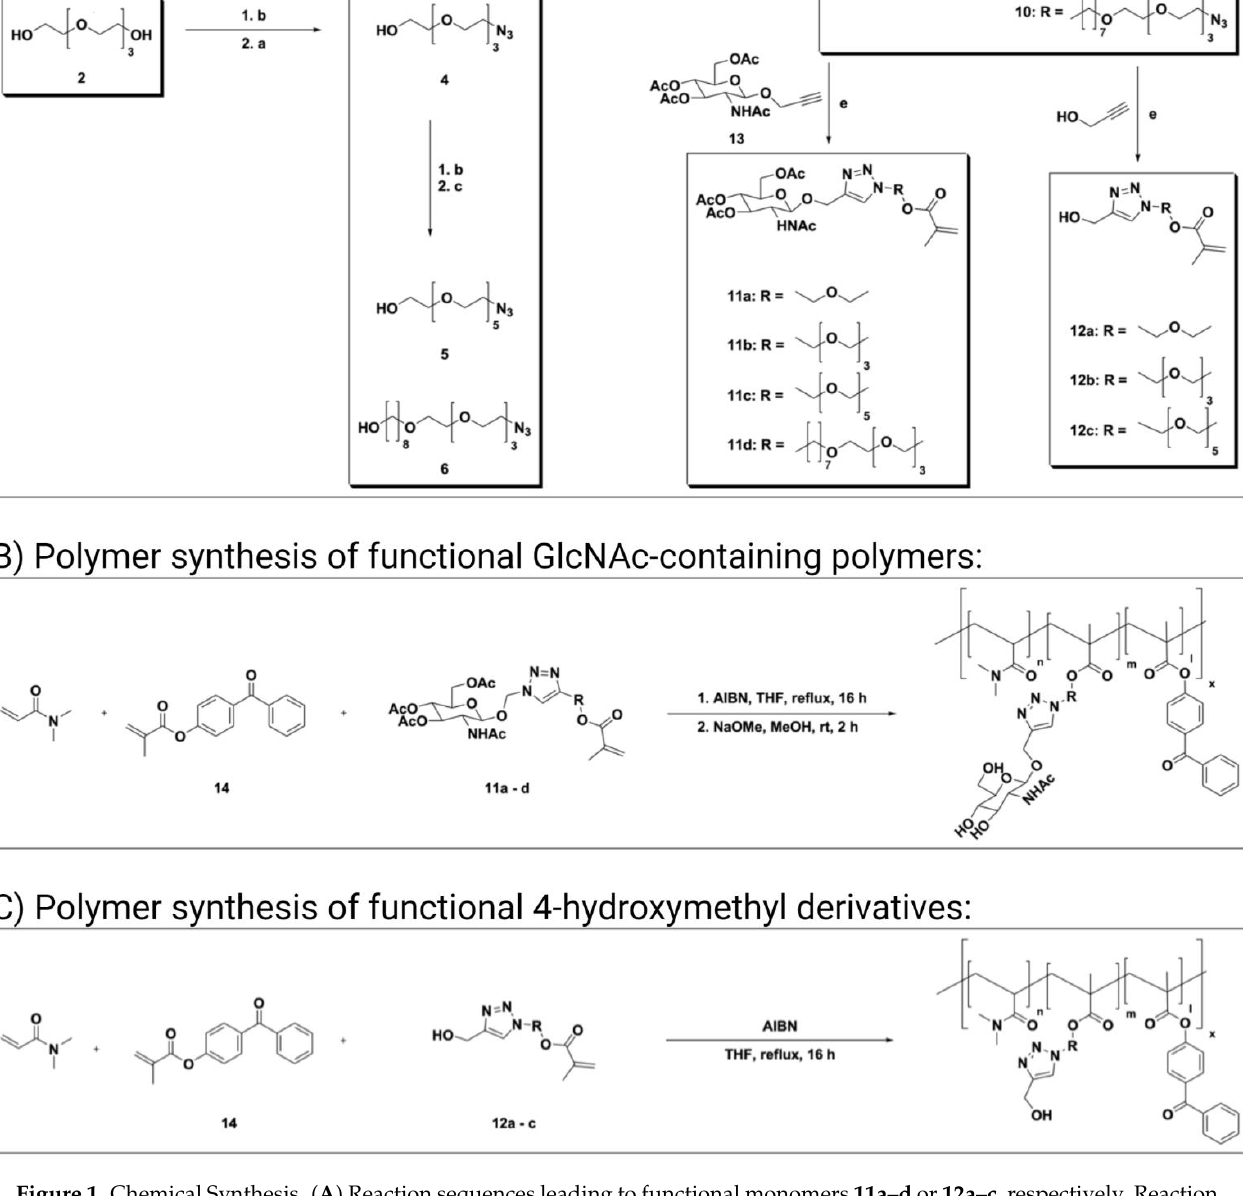
Figure 1. Chemical Synthesis. ( A ) Reaction sequences leading to functional monomers 11a – d or 12a – c , respectively. Reaction conditions: ( a ) NaN 3 , CH 3 CN, reflux, 16 h; ( b ) TsCl, NEt 3 , CH 2 Cl 2 , rt, 16 h; ( c ) NaH, THF, reflux, 48 h; ( d ) methacryloyl chloride, NEt 3 , CH 2 Cl 2 , 0 °C – rt, 16 h; and ( e ) CuSO 4 , TBTA, Na ascorbate, H 2 O/MeOH/CH 2 Cl 2 3:10:10, 60 °C, 1 h. ( B ) Polymer synthesis of functional N -acetylglucosamine (GlcNAc)-containing polymers. Benzophenone methacrylate 14 was copolymerized with glycosidic monomers 11a – d by free radical polymerization with AIBN, followed by Zemplén deprotection. ( C ) Polymer synthesis of functional 4-hydroxymethyl derivatives using 4-hydroxymethyl-[1,2,3]-triazo-1-yl derivatives of functional monomers 12a – c of the polymers with AIBN.